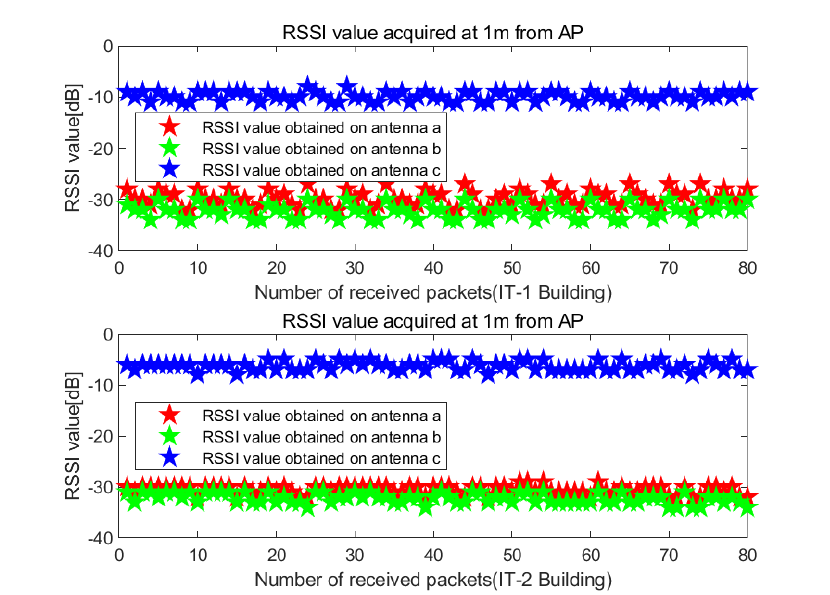
Figure 10. RSSI values obtained on different antennas in different indoor environments.